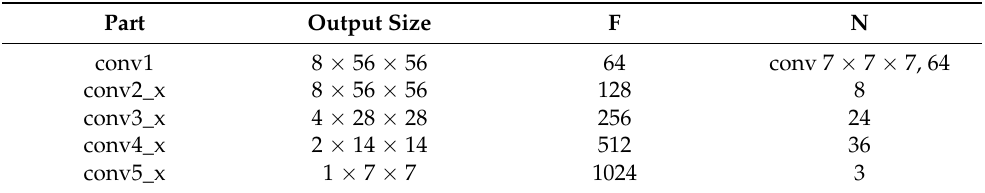
Figure 5. The architecture of our activity recognition module. Table 1. The architecture of activity feature extractor. F is the number of feature channels correspond- ing in Figure 6, and N is the number of blocks in each